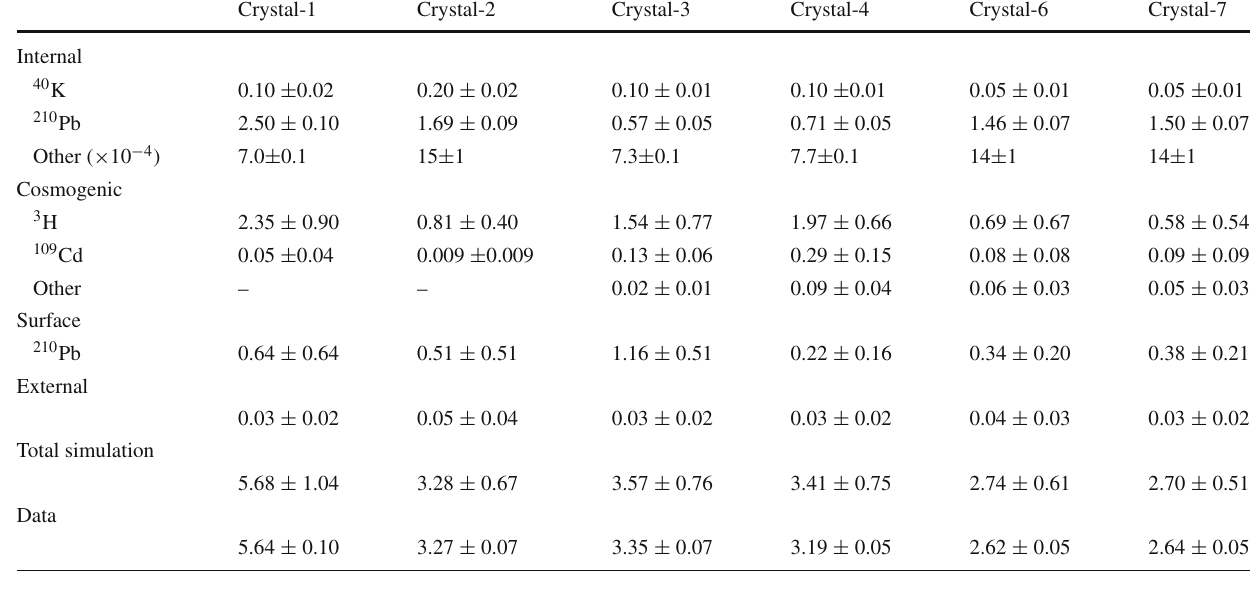
Table 4 Fitted background events in units of dru (counts/day/keV/kg) in the (2–6) keV energy interval